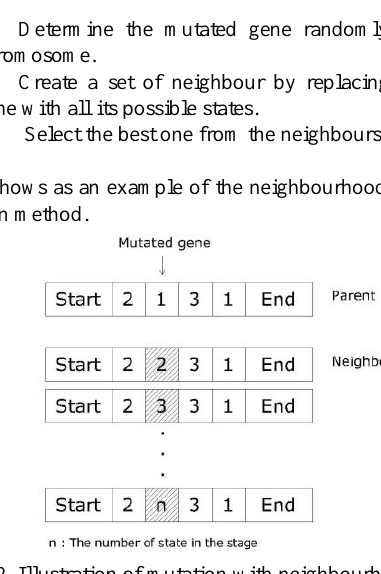
Fig. 2. Illustration of mutation with neighbourhood search.